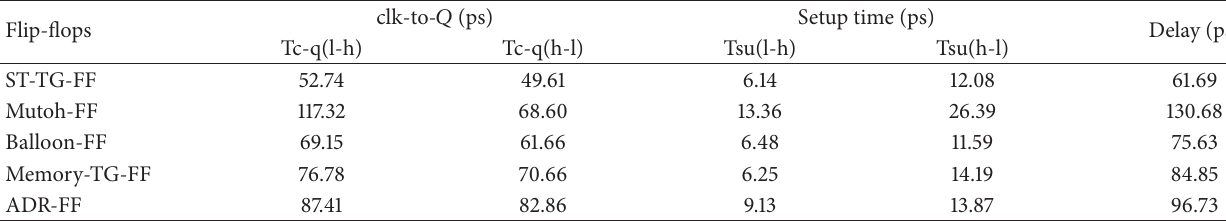
Table 4: Delay of different flip-flops.